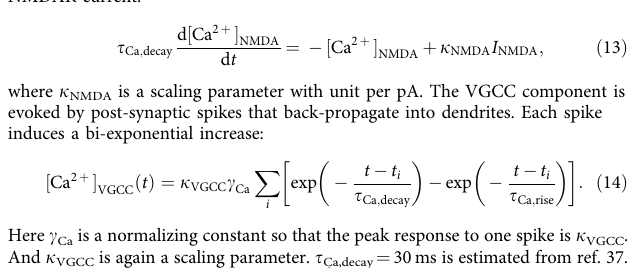
The mid-point g 1/2 is proportional to the total inhibitory conductance (cid:2) g I plus the leak conductance of the dendrite g L,D , as expected from the constant conductance scenario (Supplementary Fig. 2c)